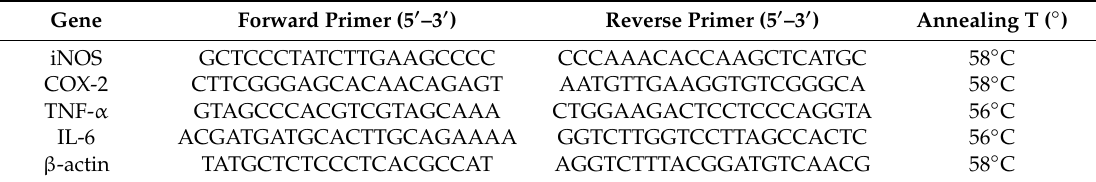
Table 1. Primer sequences used in the RT-PCR